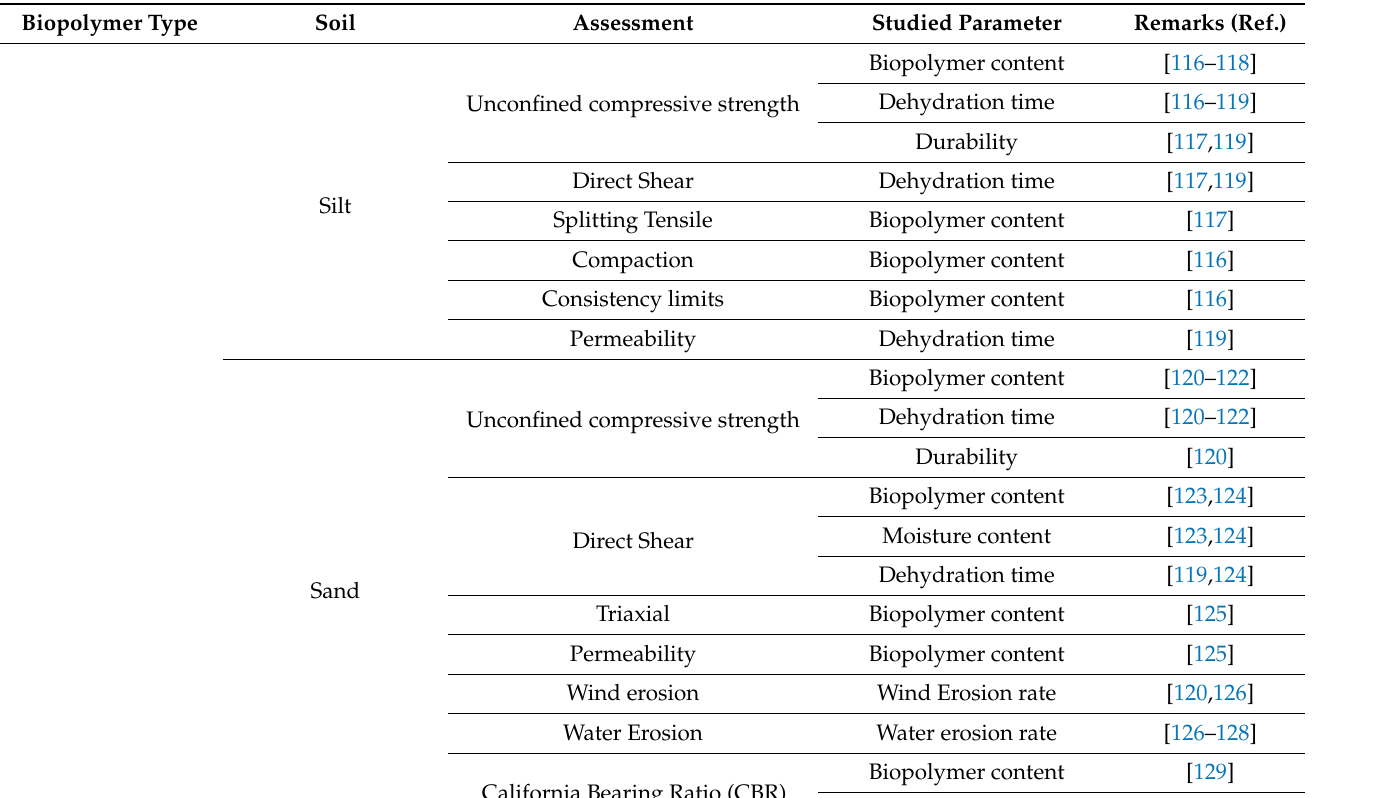
Table 2. A summary of recent studies on biopolymer-treated